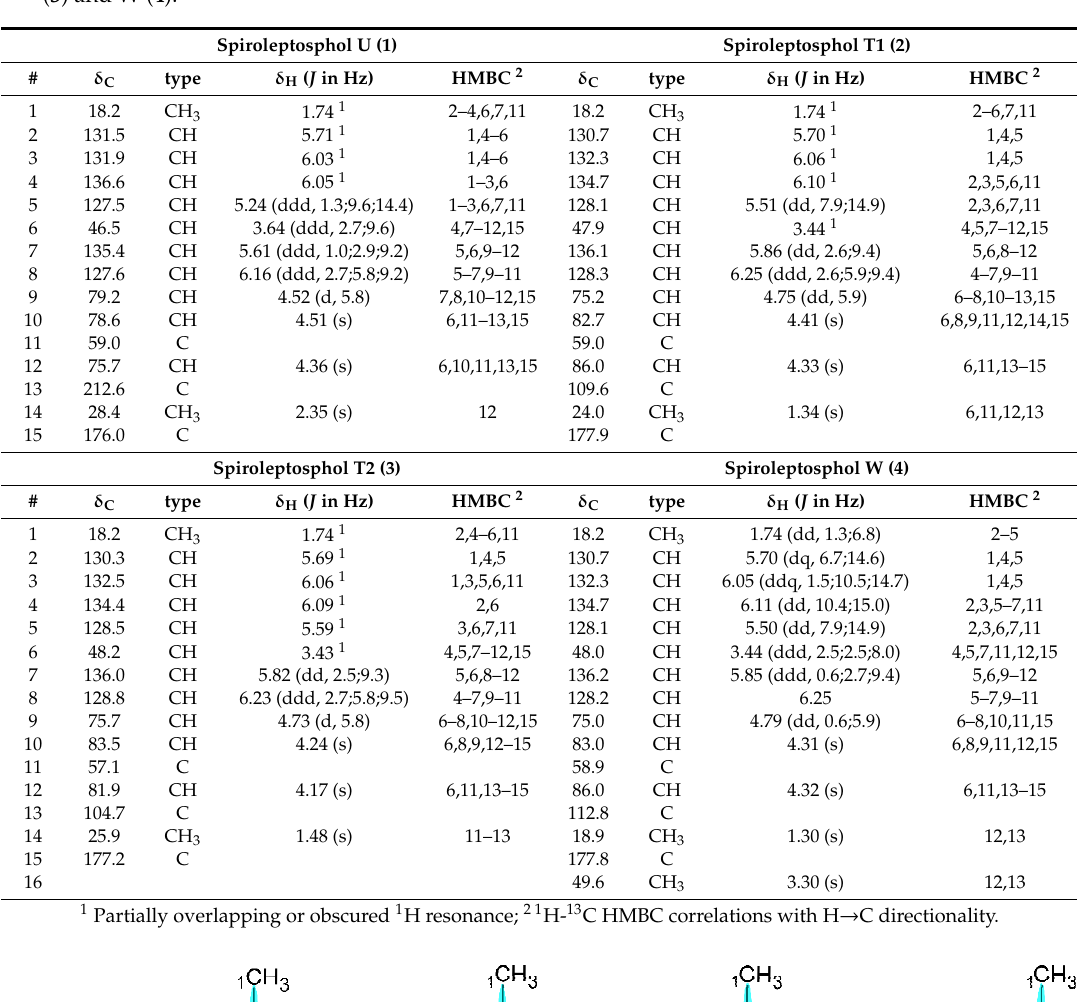
Table 1. NMR spectroscopic data (600 MHz, methanol-d 4 , 298.1 K) of spiroleptosphol U ( 1 ), T1 ( 2 ), T2 ( 3 ) and W ( 4 ).